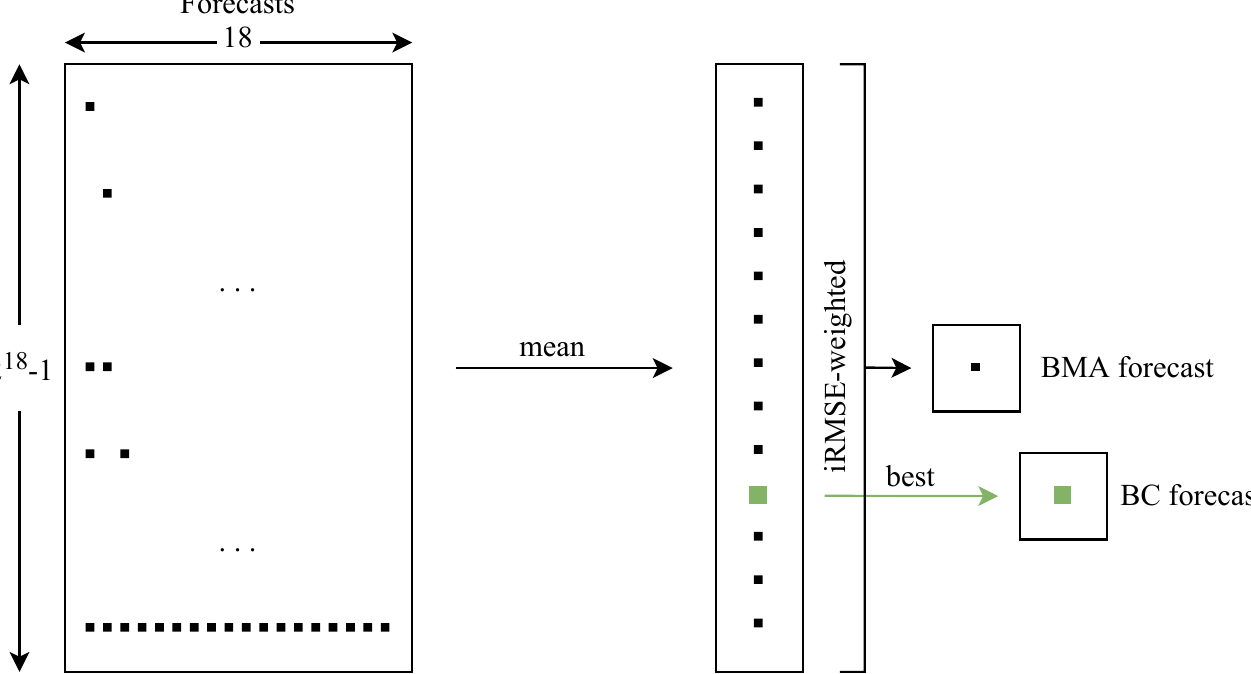
Figure 4. An illustration of the BC and BMA-type averaging schemes. For both approaches, all possible combinations (2 18 1 rows in the left rectangle) of individual forecasts for the different variants of the LTSC (2 − representing two orders of applying transformations, VST[SD( filter’s λ s; see also Table 2) are generated. Subsequently, the predictions of all models for a given combination are averaged using the arithmetic mean and either the best-performing combination in terms of RMSE in the model selection window is selected ( BC) or all combined forecasts are iRMSE-weighted ( →